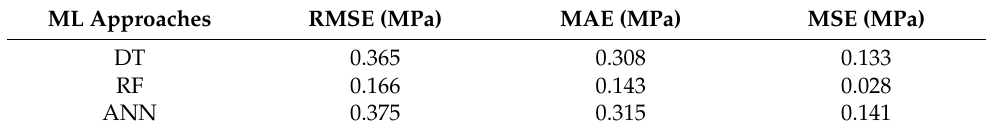
Table 3. Results of the employed